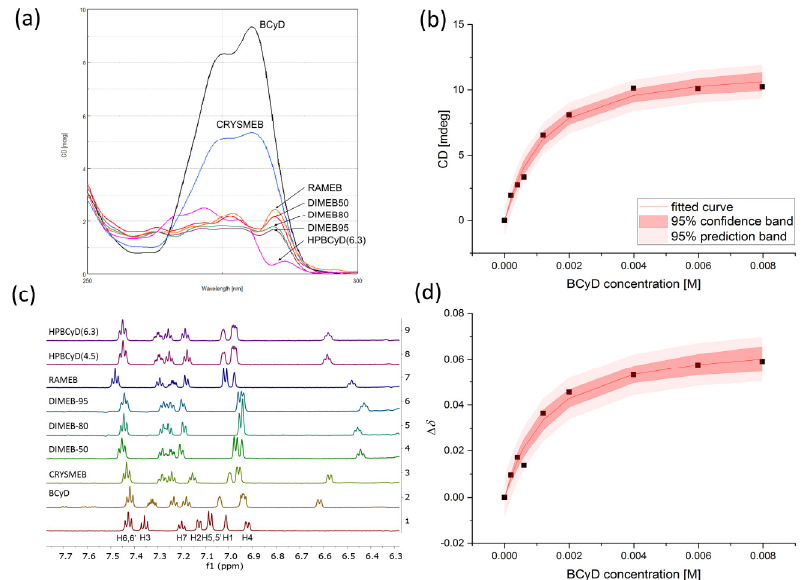
Figure 4. ( a ) The induced CD spectra of CyD-fenoprofen 1:10 in 90% H 2 O/10% methanol- d 4 . ( b ) The regression model of the ellipticity data for BCyD-fenoprofen obtained from the CD measurements at λ max . ( c ) The 1 H NMR spectra of CyD-fenoprofen 1:10 complexes in 90% H 2 O/10% methanol- d 4 . ( d ) The regression model of the H2 NMR signal of BCyD-fenoprofen (obtained from global